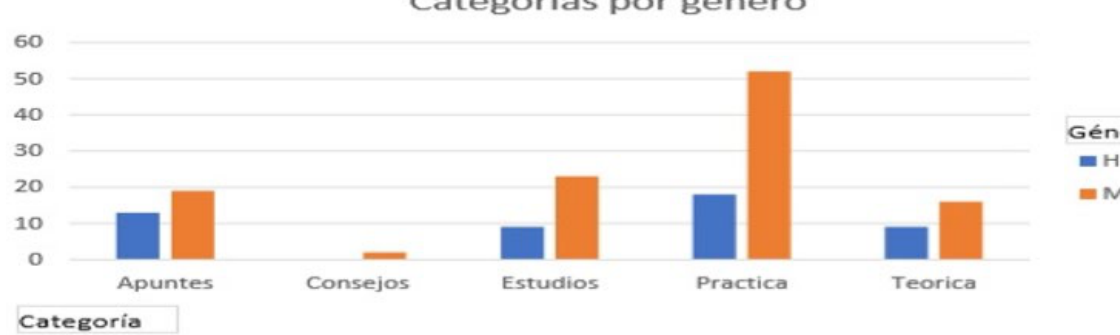
Figure 8. Comparison among instructional materials